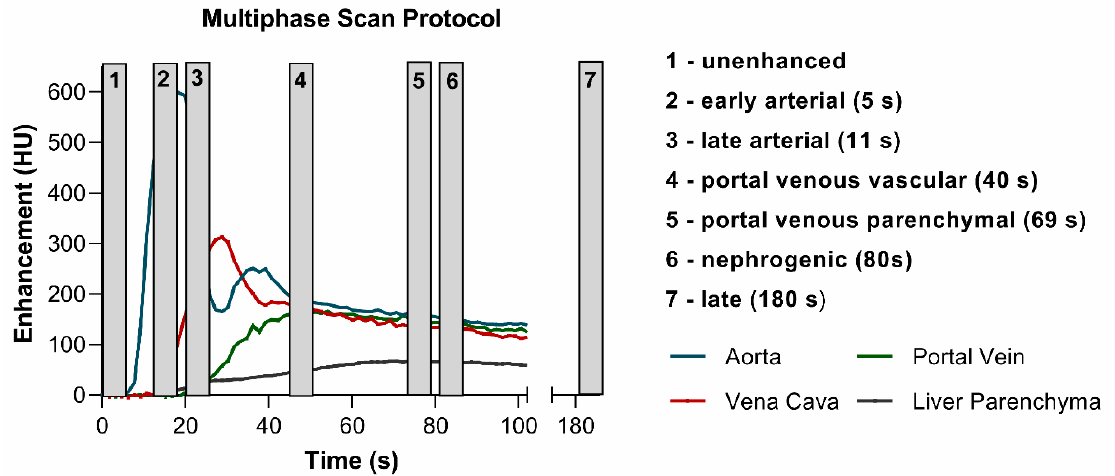
Figure 3. Multiphase scan protocol: Exemplary relative time enhancement curves of aorta, portal vein, V. cava, and the liver parenchyma superimposed with the 7 imaging phases. The start of each phase related to the bolus tracking is given in brackets.